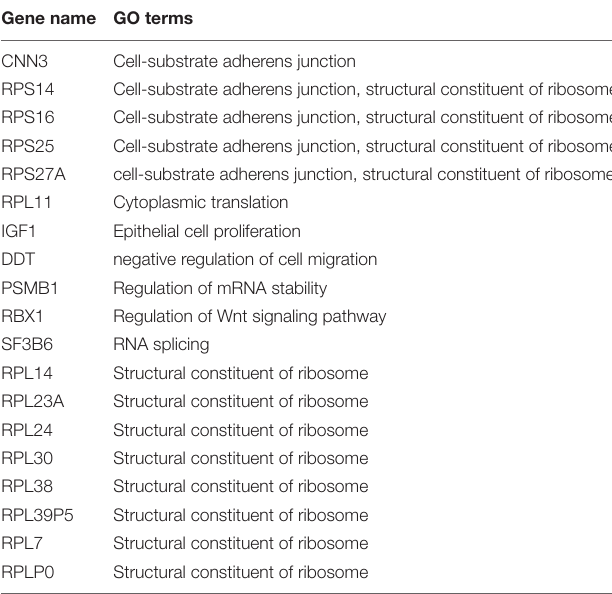
TABLE 1 | The potential target genes of differential expressed m 6 A RNA methylation regulators in the eutopic